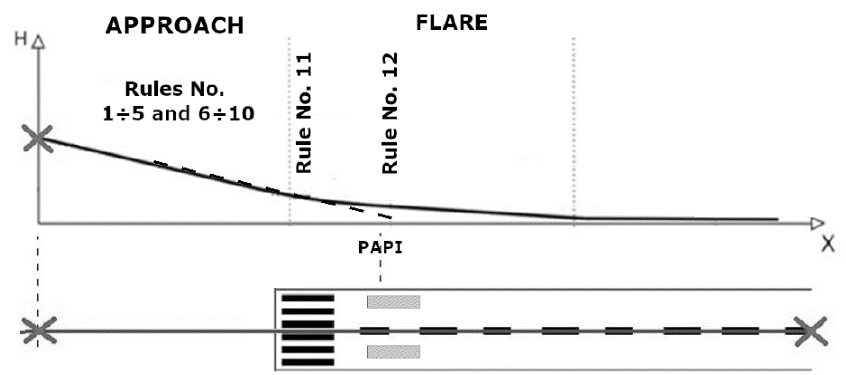
Figure 13. Membership degree of the output variable of throttle lever position δ T associated with fuzzy sets: very small, small, medium, big, and very big.